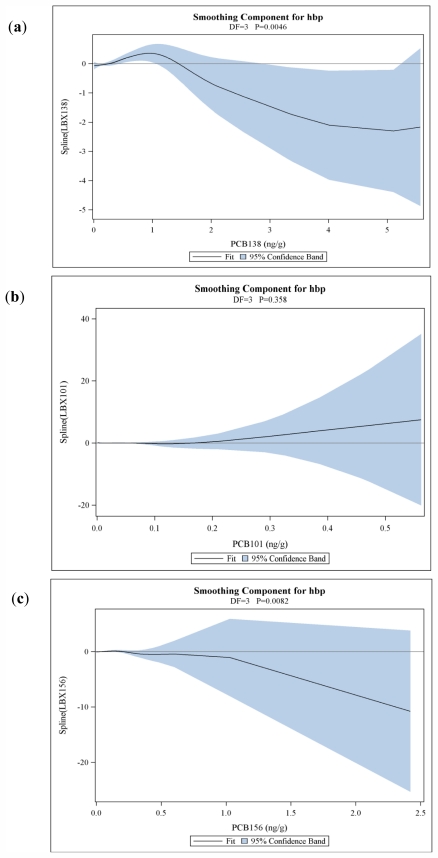
Partial prediction plots for PCBs (a) 101, (b) 138, and (c) 156, using GAM models adjusted for age in years, sex, BMI at exam, race/ethnicity, current smoking status, regular physical activity status, family history of cardiovascular disease, total cholesterol and serum lipid concentration.